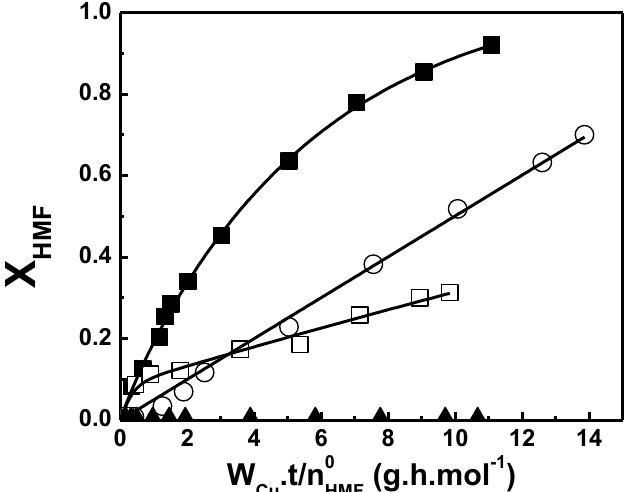
Figure 6. Conversion ( X HMF ) as a function of W Cu . t / n 0 in the liquid-phase hydrogenation of HMF on Cu − based catalysts (T= 393 K, P H2 = 15 bar, C 0 HMF = 0.13 M, V SOLV = 150 mL of THF). ■ Cu/SiO 2 −PD, □ CuMgAl, ○ Cu/Al 2 O 3 − I, ▲ Cu/SiO 2 − I.